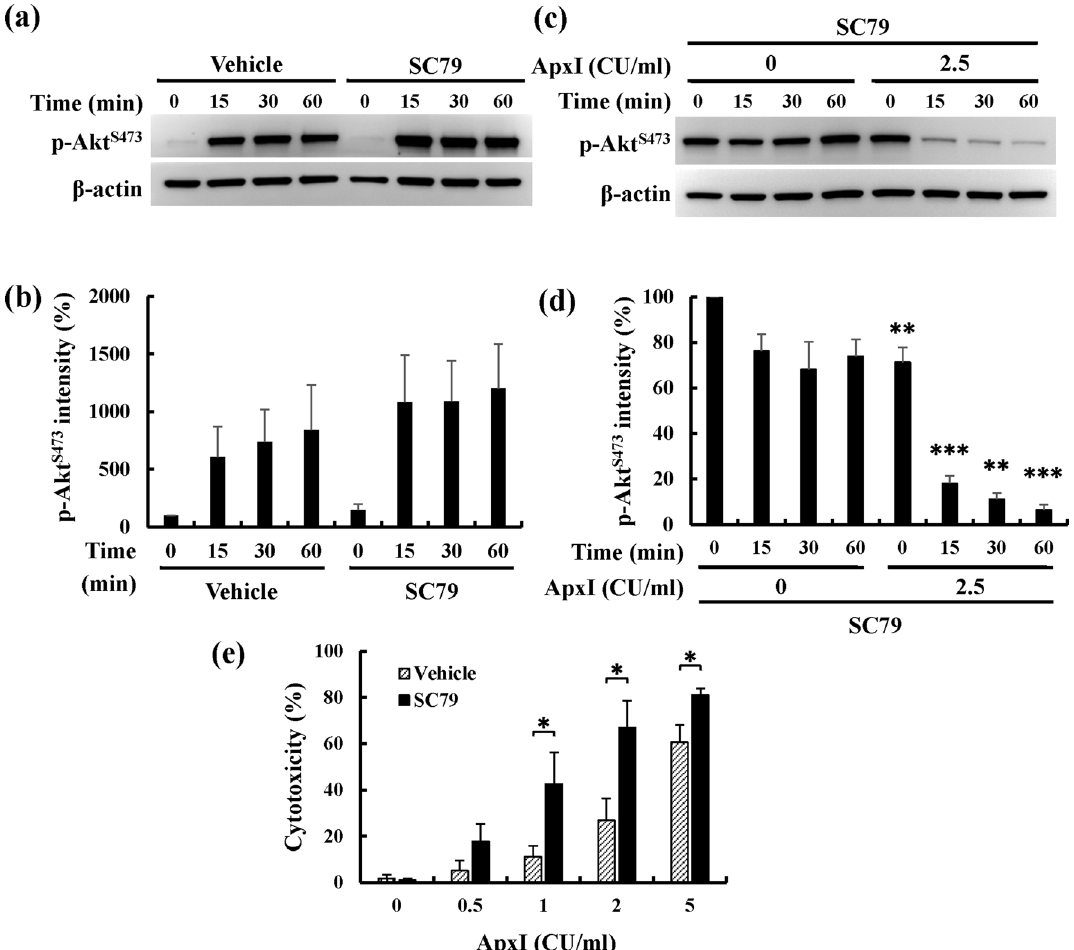
Figure 6. SC79 fails to overcome ApxI-induced attenuation of Akt and cytotoxicity. ( a , b ) Porcine AMs were treated with 4 μg/ml SC79 or 0.1% DMSO (Vehicle) for 0–60 min. Cell lysates were subjected to ( a ) Western blot analyses for p-Akt S473 . The grouping of blots was cropped from different portions of the same gel and exposed separately. Uncropped blot images for ( a ) are presented in Supplementary Figure S6. The average intensity of ( b ) p-Akt Ser473 is from three independent experiments and normalized to the intensity of β-actin. ( c , d ) Porcine AMs pretreated with 4 μg/ml SC79 for 15 min were incubated with 0 or 2.5 CU/ml of ApxI for 0–60 min. Cell lysates were harvested and subjected to ( c ) Western blot analyses for p-Akt S473 . The grouping of blots was cropped from different portions of the same gel and exposed separately. Uncropped blot images for ( c ) are presented in Supplementary Figure S7. The average intensity of ( d ) p-Akt Ser473 is from three independent experiments and normalized to the intensity of β-actin. Asterisks indicate significant differences compared to the non- ApxI treatment group at the identical time point. ( e ) Porcine AMs were incubated with 4 μg/ml SC79 or 0.1% DMSO (Vehicle) for 15 min, then stimulated with 0–5 CU/ml of ApxI for 90 min. The percent cytotoxicity was quantified using the LDH release assay. Data are from three independent experiments of triplicate determinants. * p < 0.05; ** p < 0.01; *** p < role in ApxIII-induced leukocytolysis 15 . Because CD18 is a common subunit among β 2 integrin family members, the possible involvement of other β 2 integrin members in the effects of Apx cannot be excluded. The present study identified the ApxI-induced attenuation of FAK and Akt in porcine AMs. The levels of p-FAK Tyr397 and p-Akt Ser473 were significantly reduced shortly after exposure to ApxI. Phosphorylation at Tyr397 is an important step in FAK activation and its subsequent interaction with Src and other downstream signaling molecules to transduce the integrin signal supporting cell survival 20,29 . Decreases in FAK and Akt activity likely indicate the first wave of ApxI-induced signaling events. Comparison of the kinetics of FAK and Akt attenuation upon ApxI exposure suggested that FAK was downstream of β 2 integrin and upstream of Akt in ApxI-modulated signaling. However, ApxI may attenuate the activity of FAK and Akt via independent pathways, a possibility that warrants further study. Based on our finding that ApxI attenuated FAK/Akt activity, we hypothesized that downregulation of FAK/ Akt signaling could lead to cell death and that an increase in FAK/Akt activity could rescue cells from ApxI cytotoxicity. We used the chemical activators PMA and SC79 to increase FAK and Akt activity, respectively. However, these activators failed to overcome the ApxI-induced attenuation of FAK and Akt activity and enhanced